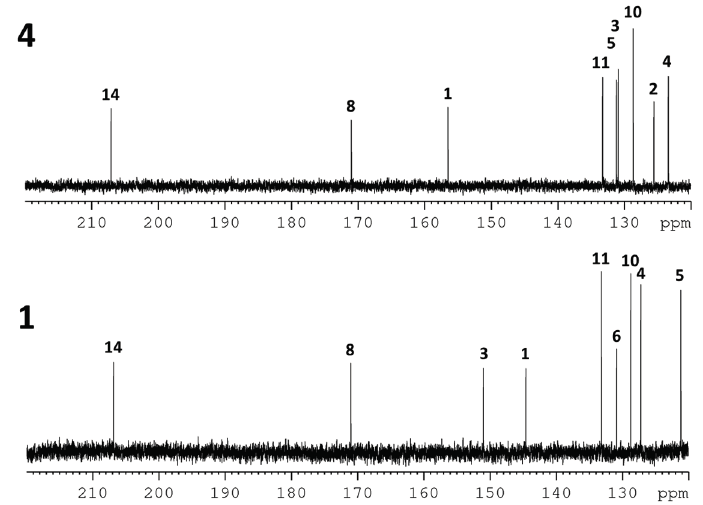
Figure 3. Partial 13 C-NMR spectra (125 MHz) of isolated salicortin ( 1 ) and idescarpin ( 4 ) in MeCN- d 3 with position numbering according to Figure